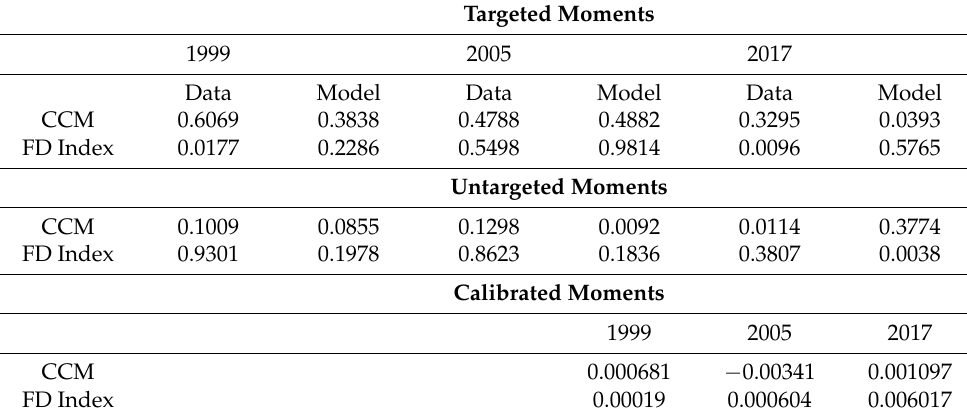
Table 4. Internal calibrated moments (targeted and untargeted).